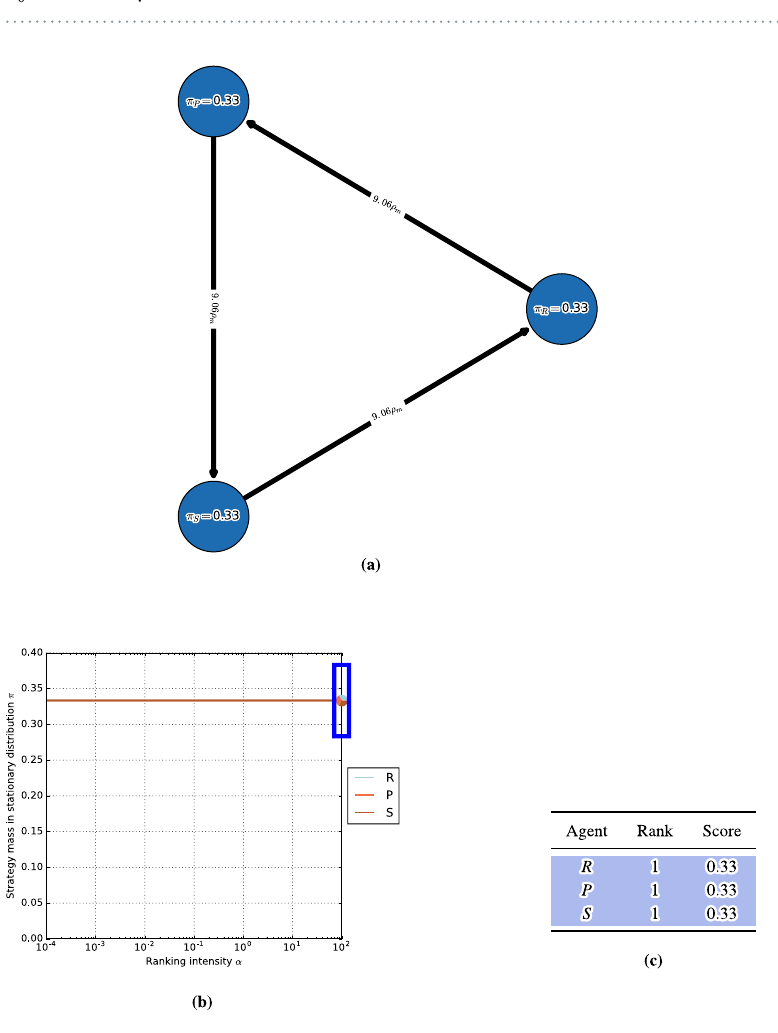
Figure 5. Topology of dynamical systems: an ε T ( , ) -chain from x here by the solid arrows and sequence of points x x x x x , , , , x 0 (indicated by the dashed arrow) holds for all ε > 0 and > T 0 , then it is a chain recurrent